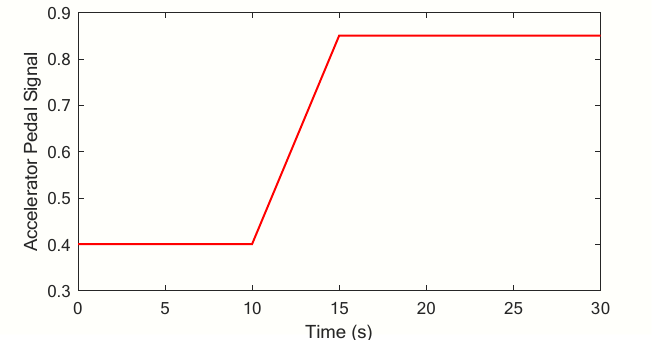
Figure 13. Steering wheel angle at a high-speed small-steering-angle step condition.